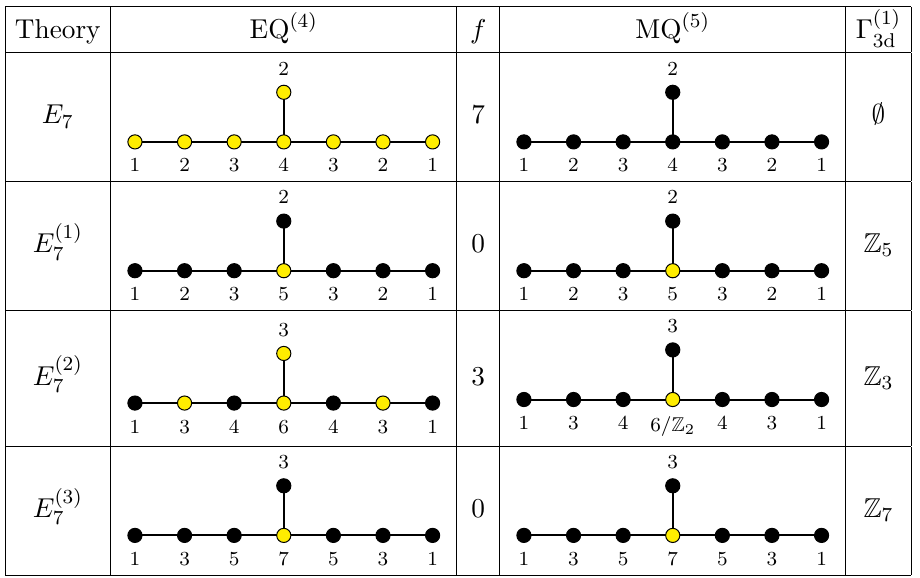
Table 5 . EQ (4) and MQ (5) for the r = 1 E 7 theories and their 1-form